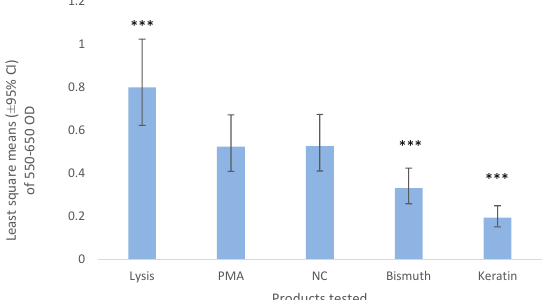
Figure 2. Least square means ( ± 95% CI) of 550–650 optical density of the neutrophils exposed to bismuth 3% and keratin 3%. HBSS was used as a negative control (NC) and 1 part of 20 µg/mL of PMA, 1 part of 50 µg/mL calcium ionophore, 1 part of 50 µg/mL cytochalasin B with 7 parts of HBSS was used as the positive control (PMA). The lysis buffer contained 0.02% hexadecyltrimethylammonium bromide. *** means p -value <